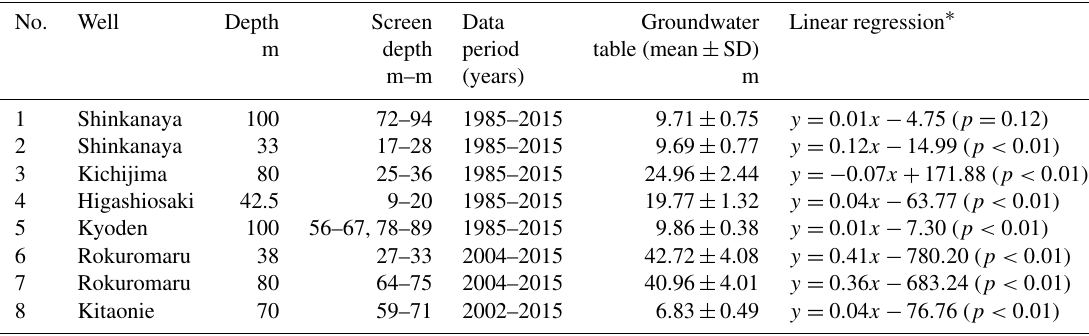
Table 1. Description of groundwater monitoring wells. No. Well Depth Screen Data Groundwater Linear regression ∗ m depth period table (mean ± SD) m–m